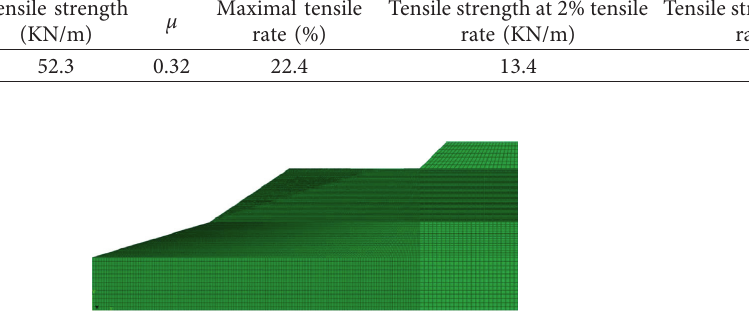
Figure 2: Computational model cell division.